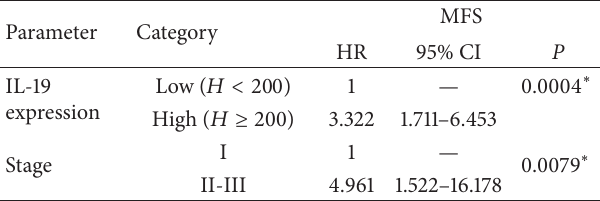
Table 3: Multivariate survival analyses for